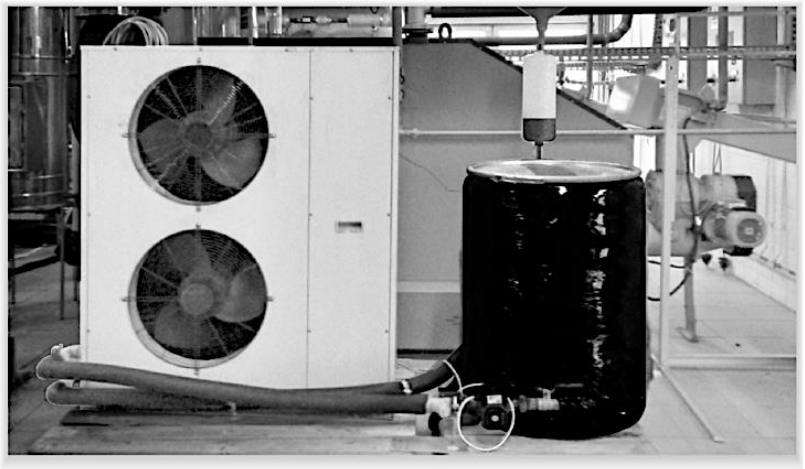
Figure 2. A view of the testing stand.